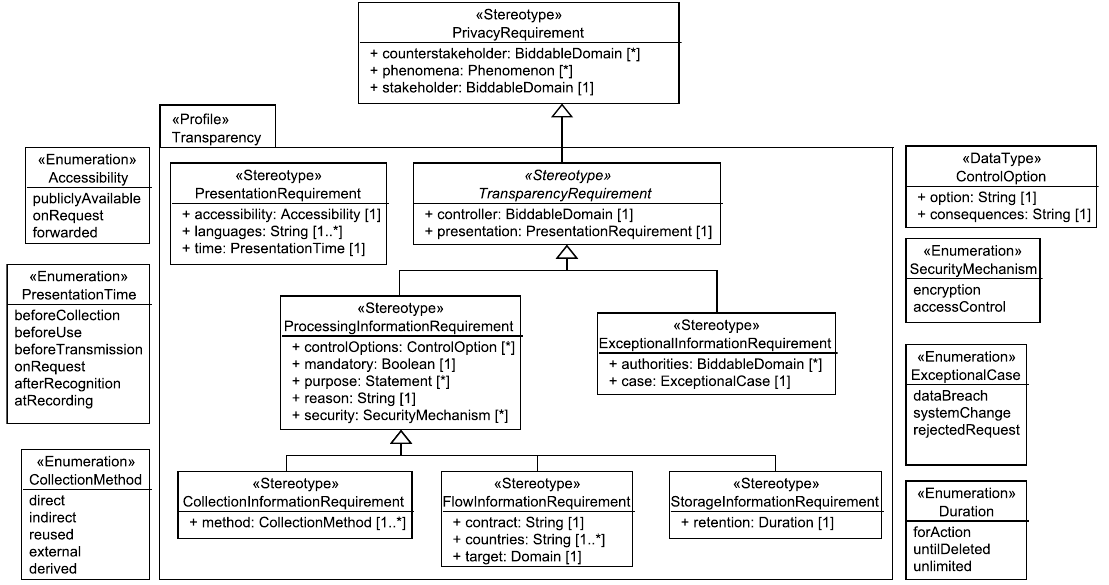
Figure 12. Used Taxonomy of Transparency